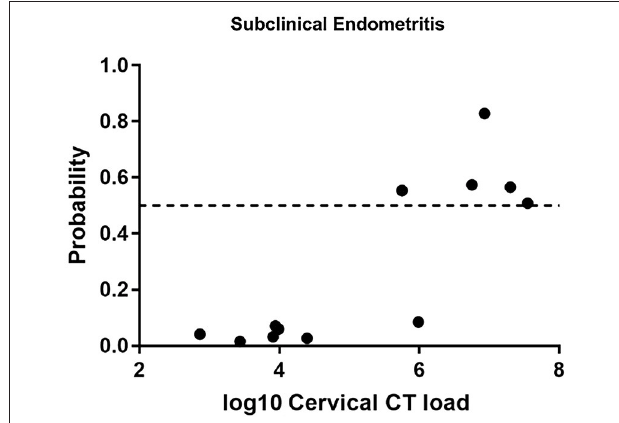
FIGURE 4 | Predicted probability using 21-gene signature and SVM of STI-induced endometritis in a target dataset of asymptomatic subjects with biopsy proven subclinical CT/GC-induced endometritis. Each dot represents one subject. The x-axis indicates the log10 cervical C. trachomatis load and the y-axis indicates the predicted probability of STI-induced endometritis.